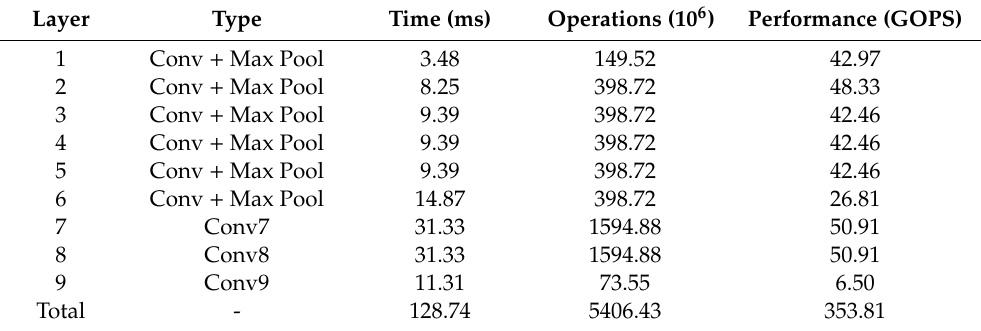
Table 3. Running time and performance per layer of YOLOv2-tiny.